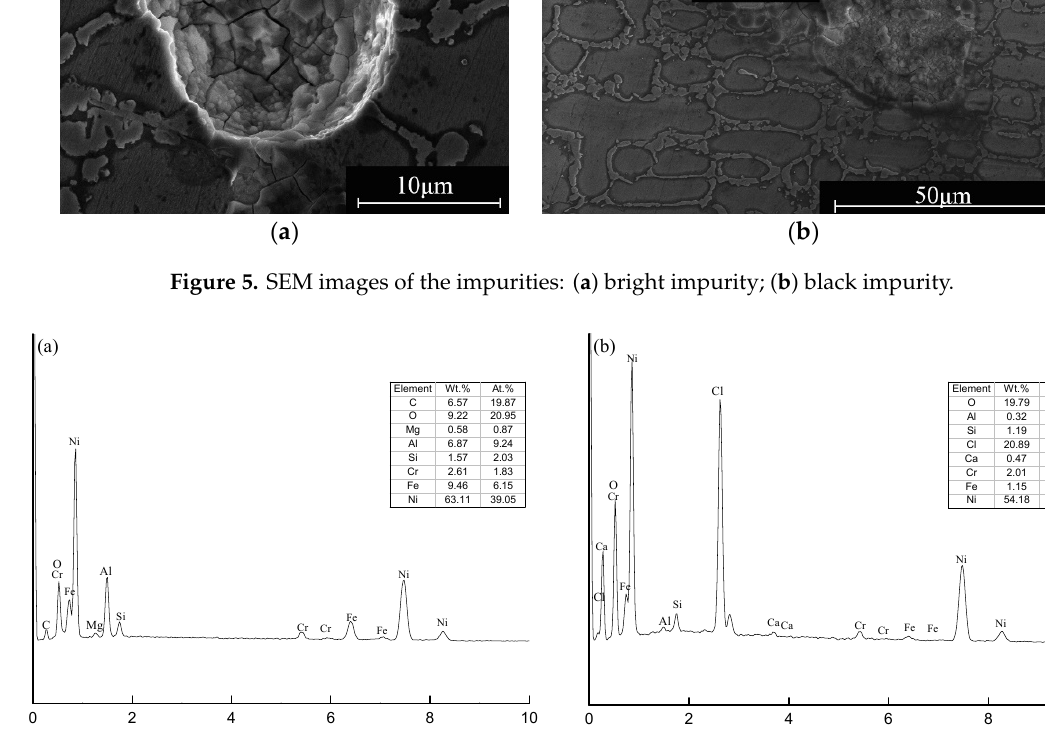
Figure 6. Energy-dispersive spectroscopy (EDS) results for the bright impurities ( a ) and black XRD impurities ( b ).